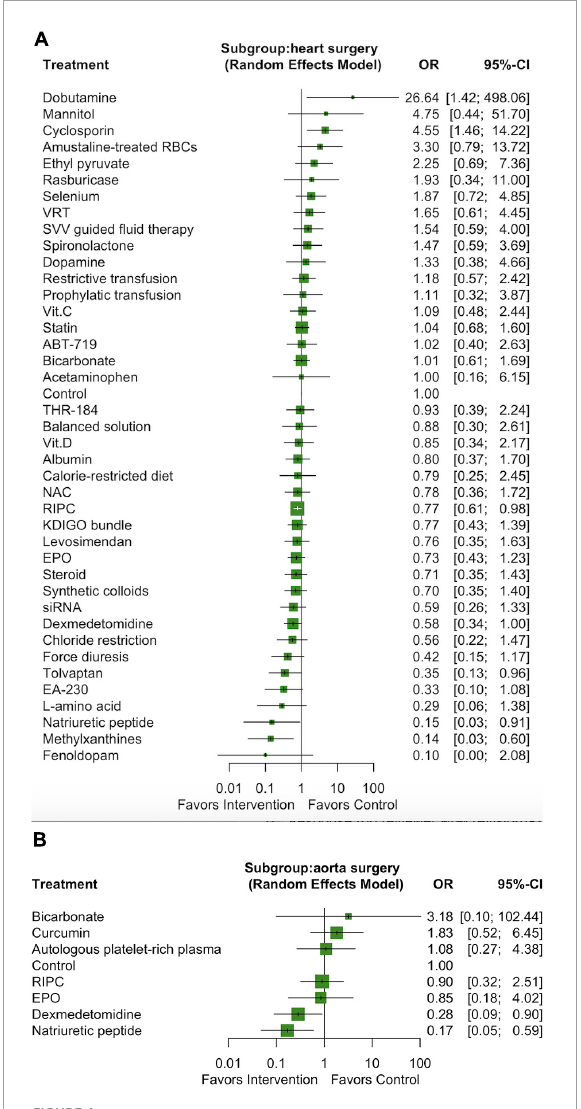
FIGURE4 Forest plot of network meta-analysis of subgroup analysis: heart surgery (A) and aorta surgery